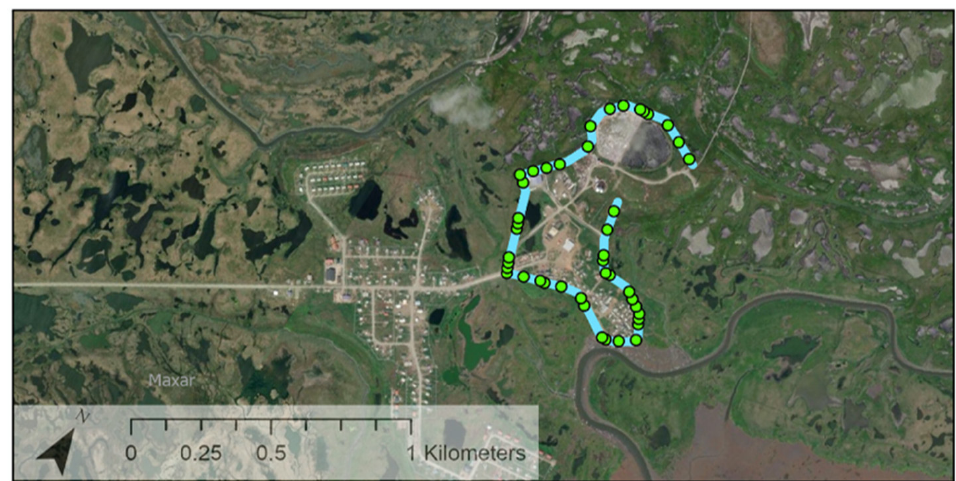
Figure 7. Model points used to estimate the roadside dike height.